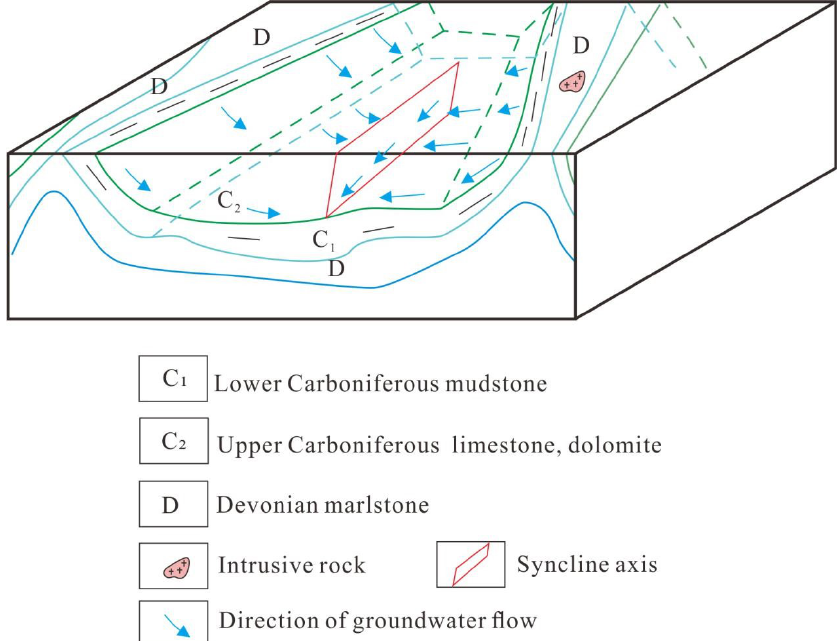
Figure 12. Fault control deep groundwater karst pattern diagram for Huanjiang